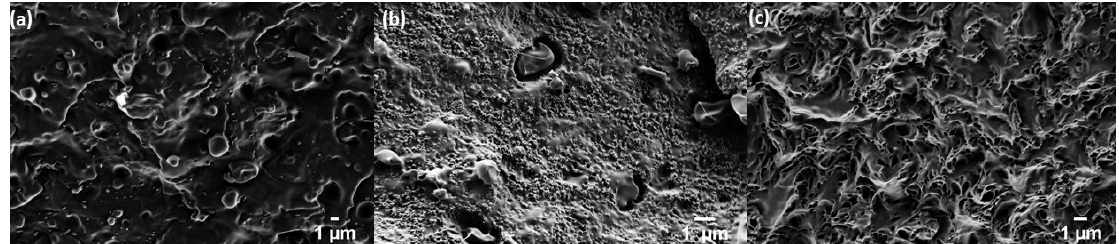
Figure 1. FE-SEM images of 80:20 PHBV:PLA with: ( a ) no nanofiller, ( b ) 6% CB, and ( c ) 6 wt.% BioC.